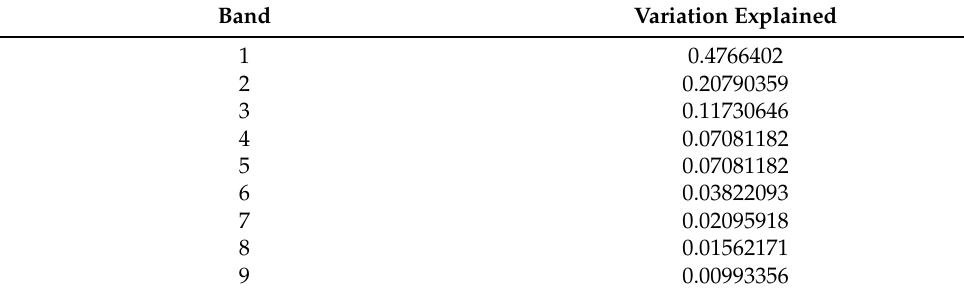
Table A20. ULS PCA Band Variation Explained at 5m Grid Size.